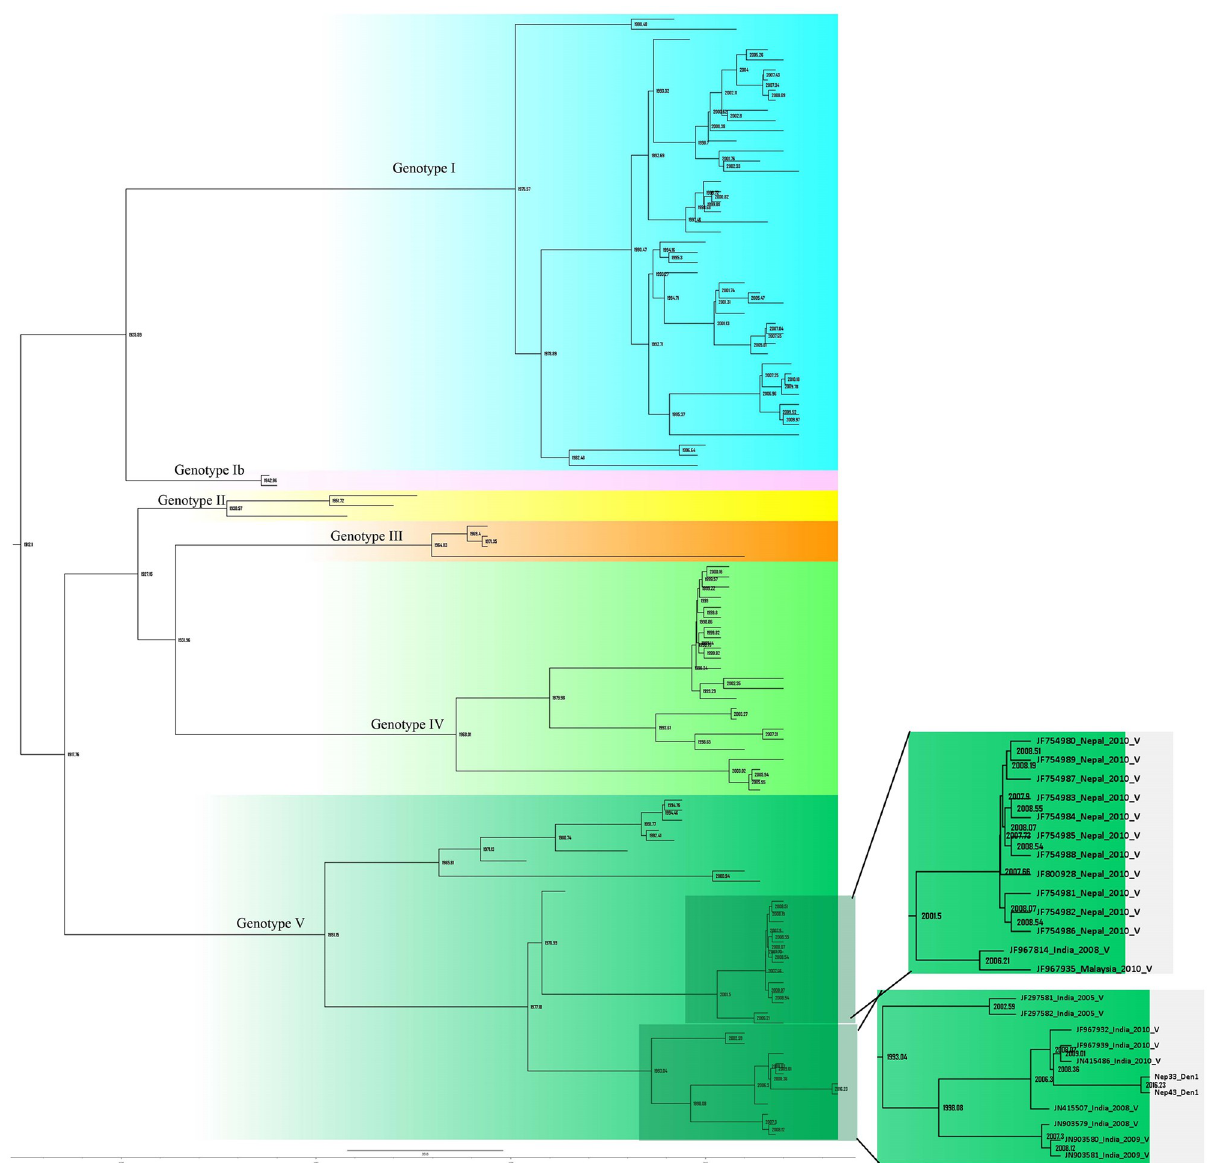
Fig 5. Phylogeny tree of DENV-1 serotype constructed using BEAST v2.5.1 using Gamma+I+T93 substitution model against Dengue genotyping database. Tree is labelled with node age at corresponding node. Detail tree with all of the sequences used for genotyping is shown in S1 Fig.